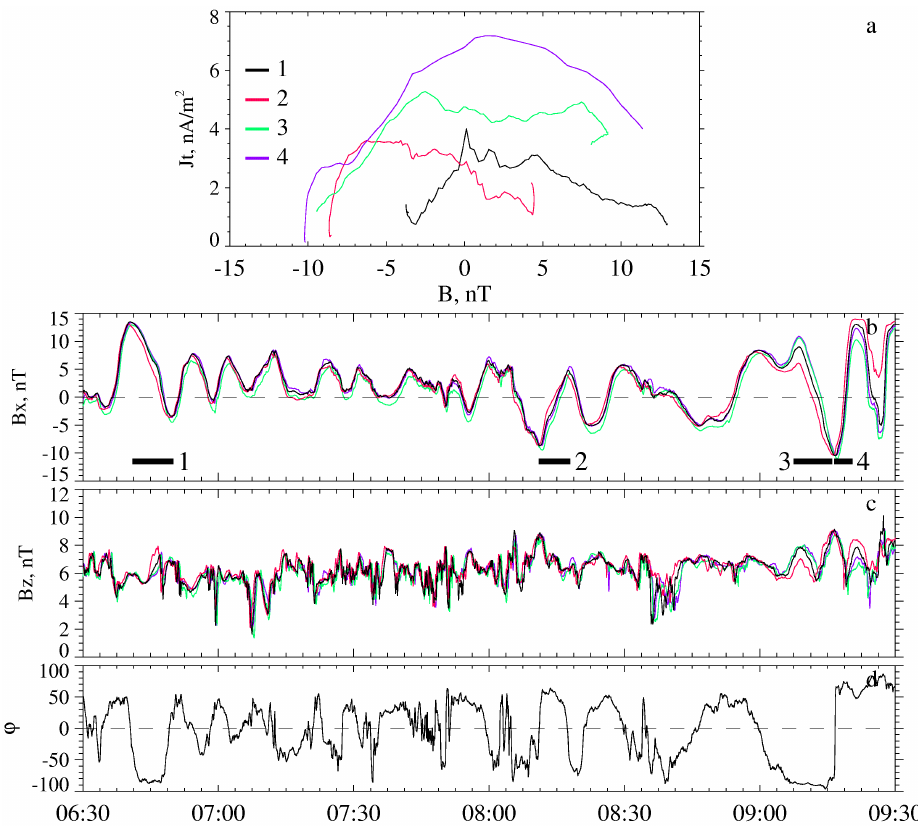
Fig. 2. The event of 3 August 2004: (a) Current density profiles across the sheet. Magnetic field B x (b) , B z (c) in GSM frame of reference and normal direction angle (d) relative to Z GSM (see Sect. 2 for details). C1,C2,C3,C4 spacecraft are denoted by standard colors – black,red,green,blue, respectively. Thick horizontal black lines in panel (b) denote the intervals of the profiles in (a). Modified from Petrukovich et al.